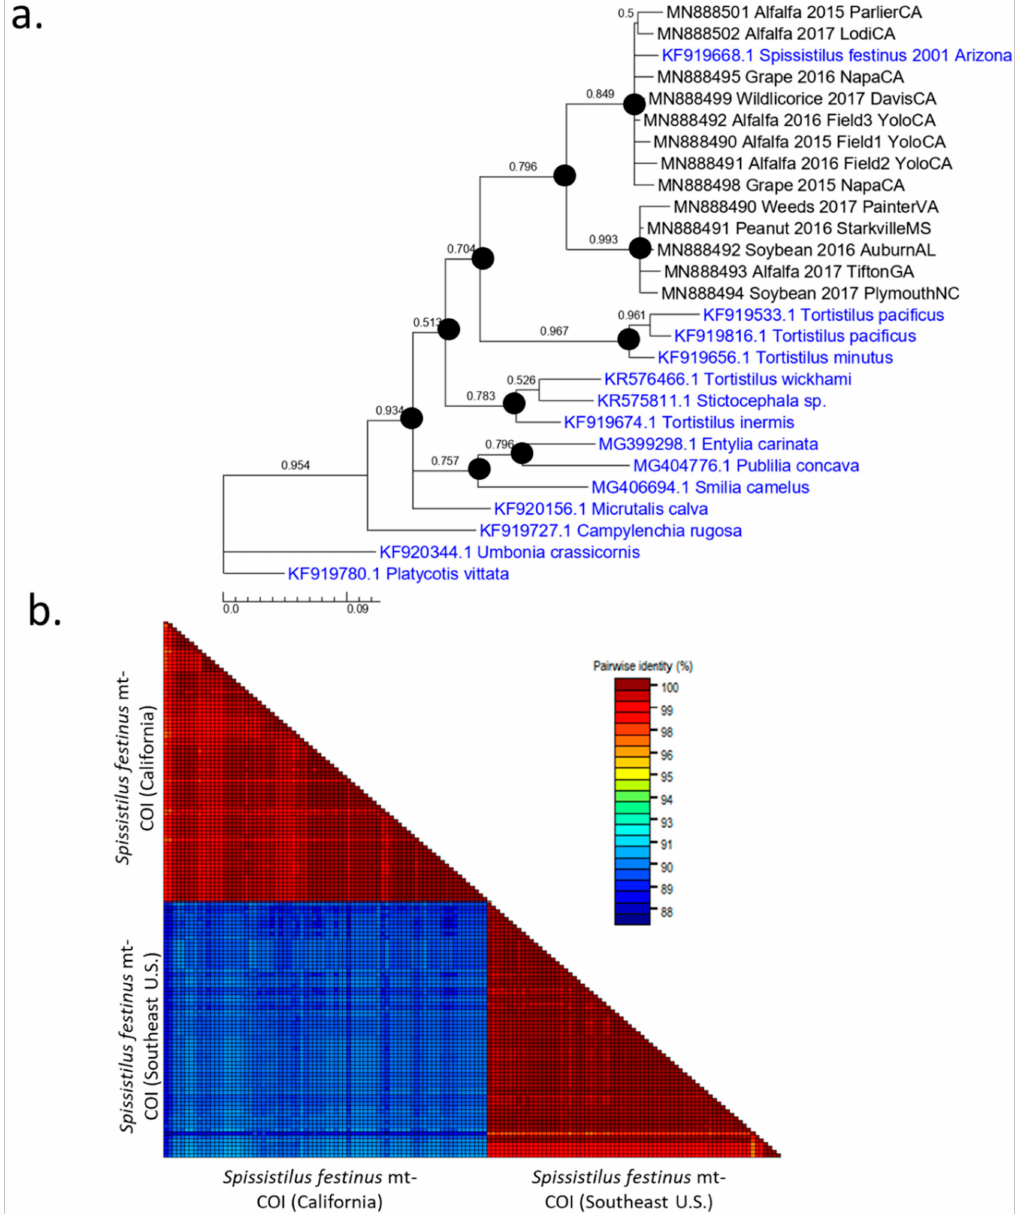
Figure 1. Analyses of mitochondrial cytochrome C oxidase I (mt-COI) consensus sequences (547 nucleotides) from Spissistilus festinus populations collected from various locations, years, and crops in California and the Southeastern United States. ( a ) Bayesian inferential analysis indicating two distinct genotypes based on geographic location. Membracid mt-COI sequences determined in this study are denoted in black; the sequences retrieved from GenBank and used for comparison are denoted in blue. Numbers at the nodes indicate Bayesian posterior probability. Nodes denoted with a black dot indicate support by Maximum Likelihood analysis with at least 90% bootstrap support (1000 bootstrap replicates). ( b ) Pairwise identity matrix based on MUSCLE alignment of sequences from individual specimens. Each square depicts a pairwise comparison, where red indicates high sequence identity ( > 98%) and blue indicates lower (88%–90%) sequence identity. Note the high homogeneity among sequences within populations, and a distinction between mt-COI sequences from S. festinus specimens from California and the Southeastern United